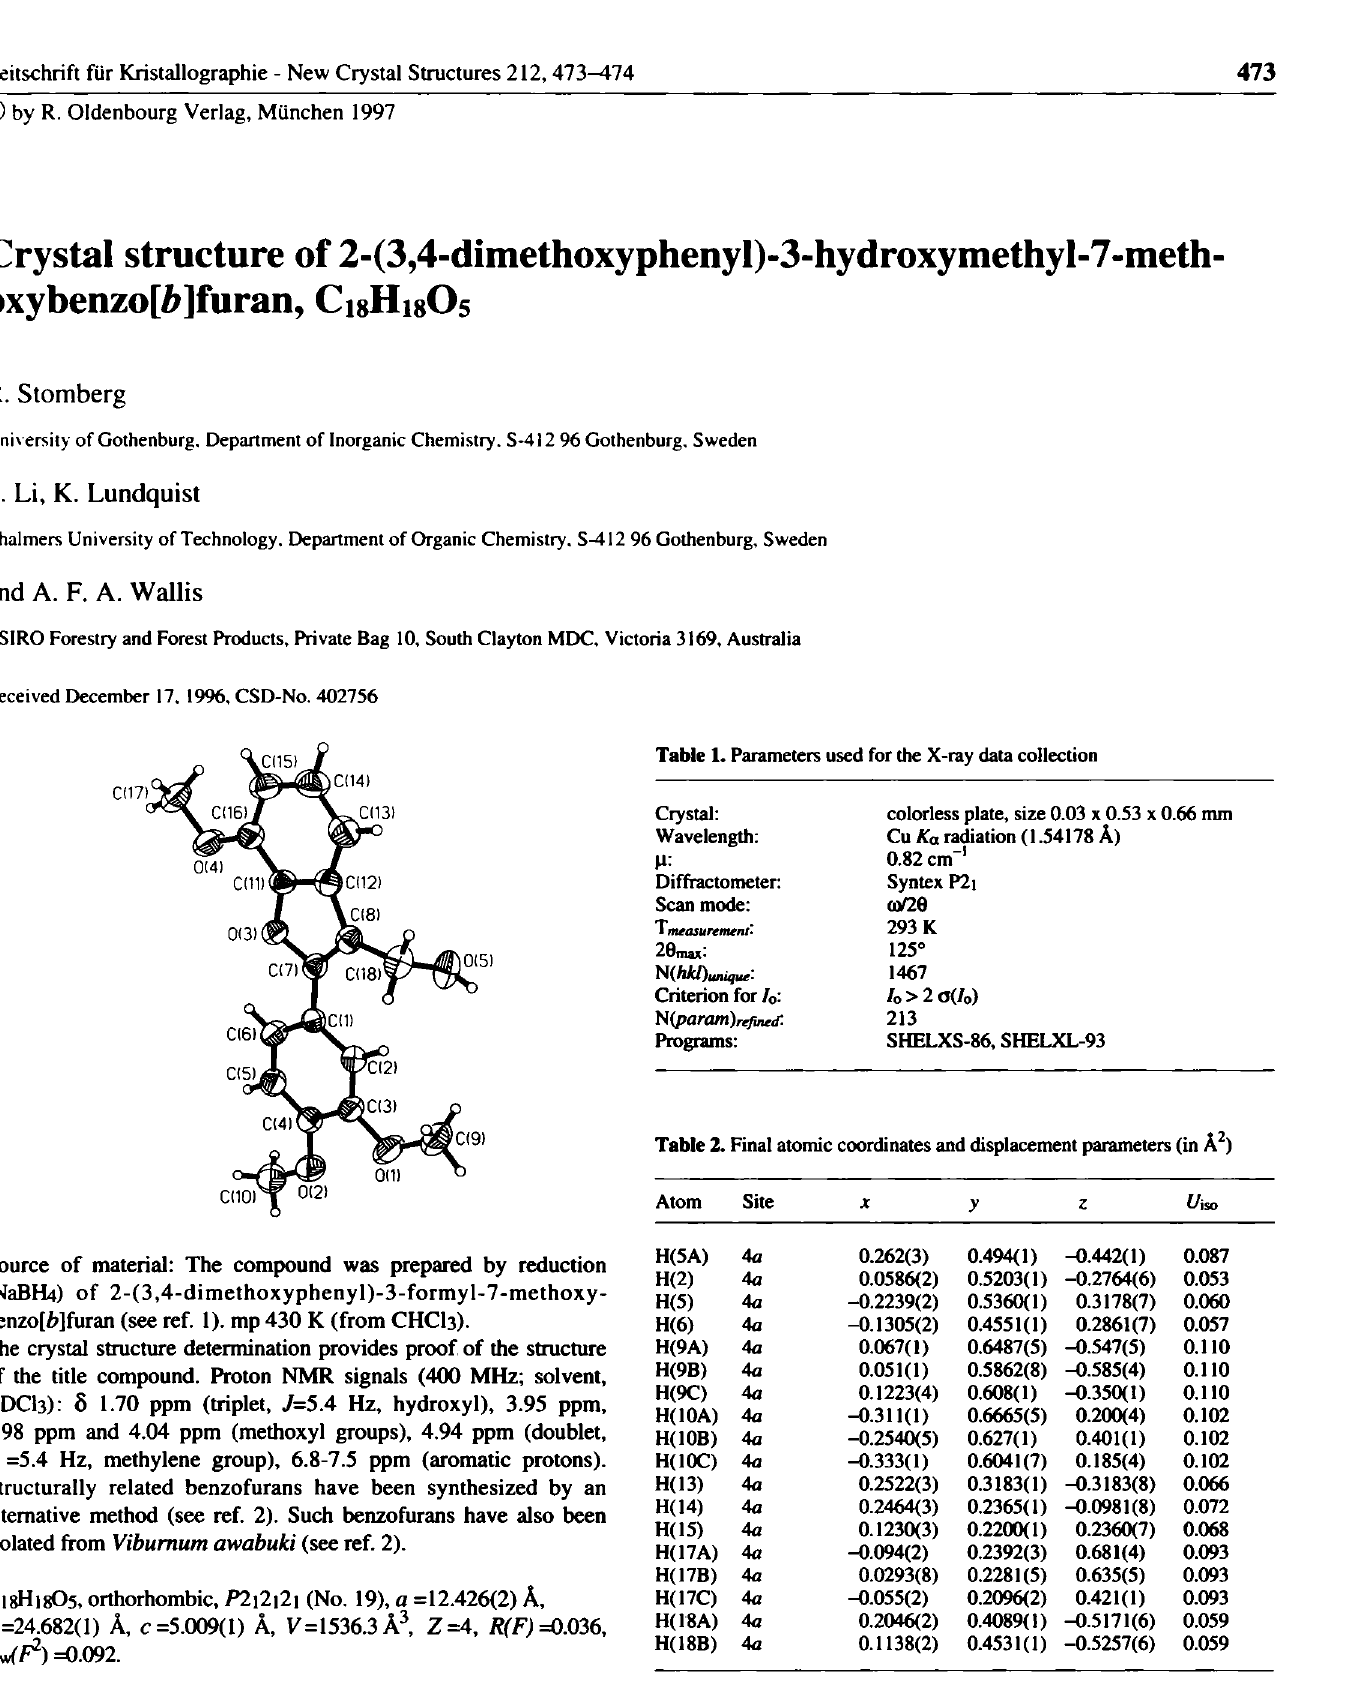
Table 3. Final atomic coordinates and displacement parameters (in Â 2 ) Atom